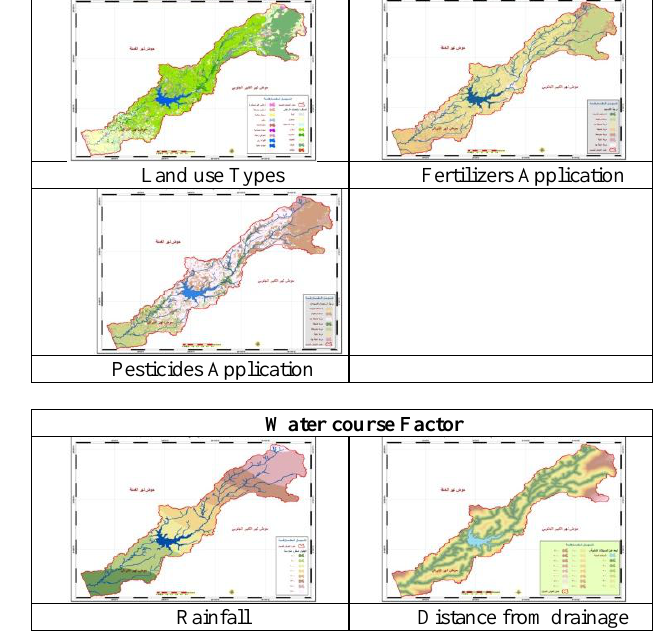
Figure 3: Factors maps of the proposed model